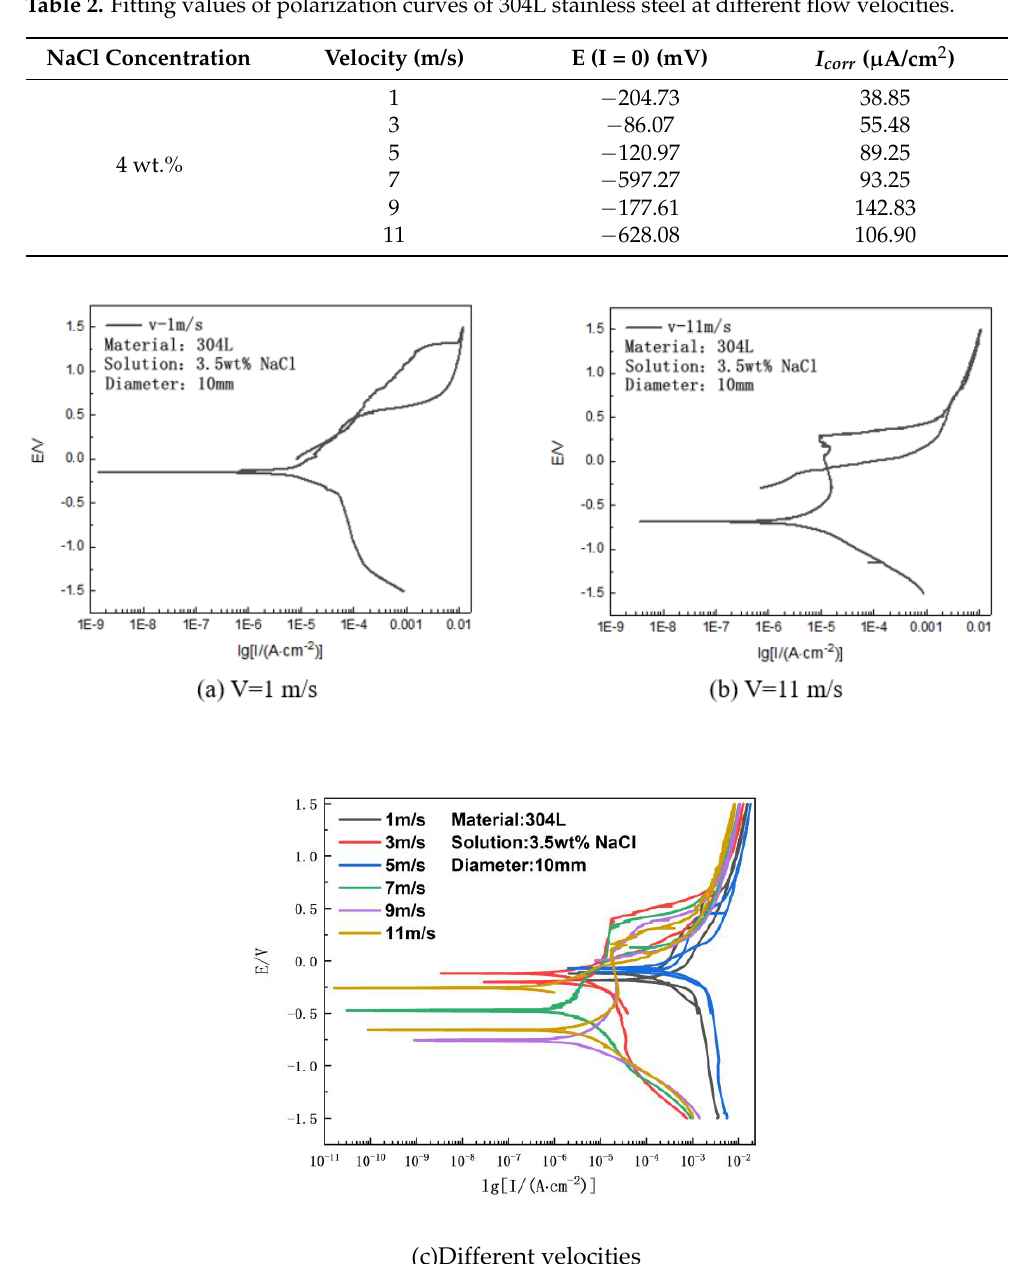
Figure 7. Cyclic polarization curves of 304L stainless steel at different flow velocities. ( a ) Cyclic polarization curves of 304L stainless steel at V = 1 m/s; ( b ) Cyclic polarization curves of 304L stainless steel at V = 11 m/s; ( c ) Cyclic polarization curves of 304L stainless steel at different flow velocities. Table 2. Fitting values of polarization curves of 304L stainless steel at different flow velocities.